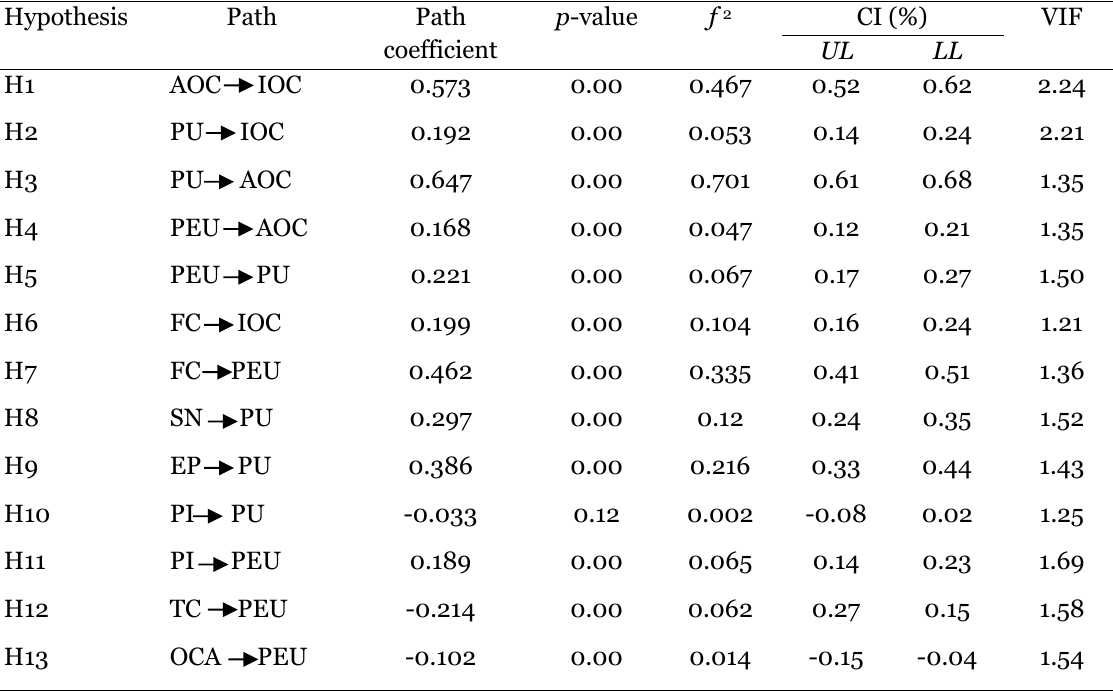
Results of the Structural Model